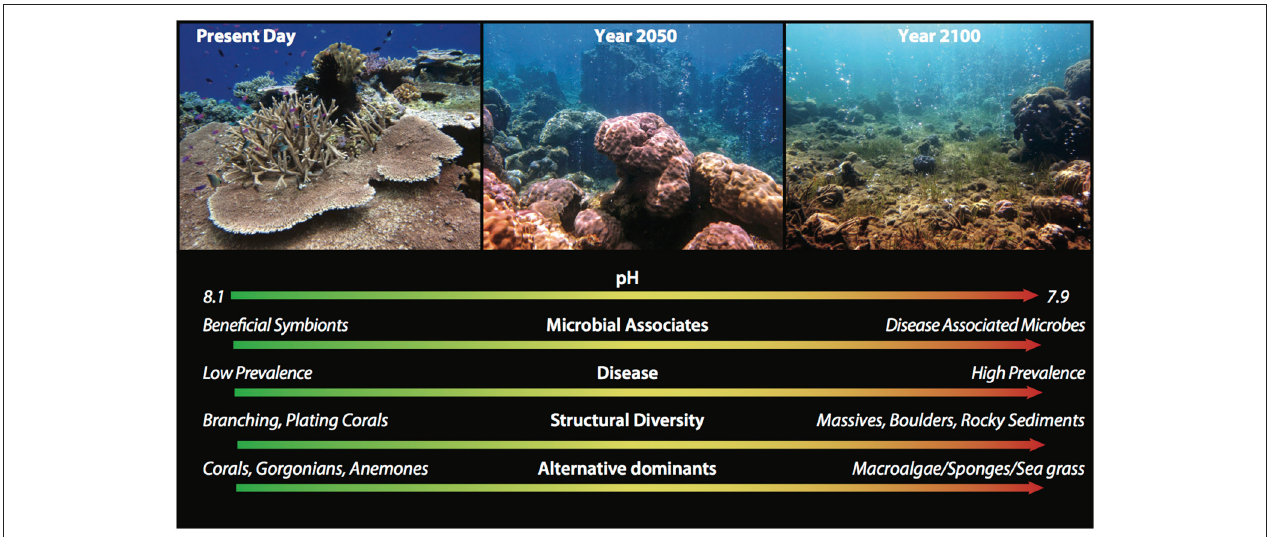
FIGURE 3 | Photos, taken along a p CO2/pH gradient in Papua New Guinea (year 2014), and text depict three potential scenarios for coral reefs under present day and future (year 2050 and 2100) OA conditions if we continue on current predicted CO 2 emissions trajectories. Present Day illustrates a healthy coral reef with high structural complexity and diversity that is likely colonized by beneficial microbial associates and experiences a low incidence of disease. As p CO 2 increases, scenarios for years 2050 and 2100 illustrate the successional degradation of coral reef heterogeneity (structural diversity), destabilization of microbial associations and increase in disease, transitioning to an alternative stable state composed of competitive dominants (e.g., sponges, macroalgae) and/or sediment/rubble. Arrows from green to red indicate the positive to negative changes a coral reef might experience over time. (Photo credit: K. Morrow).